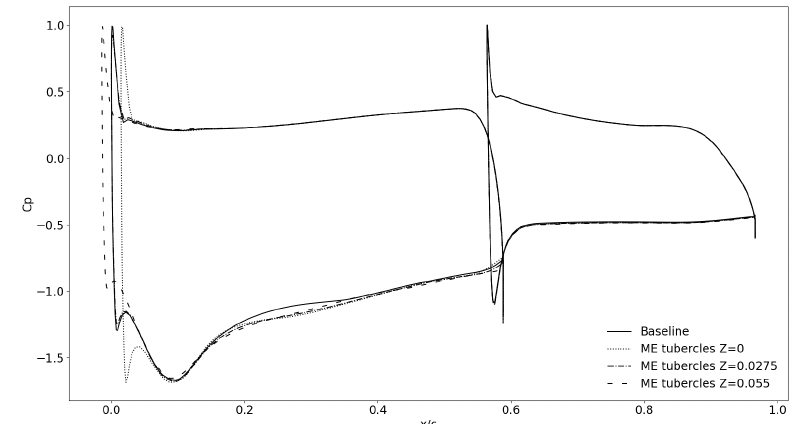
Figure 15. Comparison of the pressure coefficient along the front wing for both baseline and ME Tubercles (5 tubercles/2 A = 0.05 c )